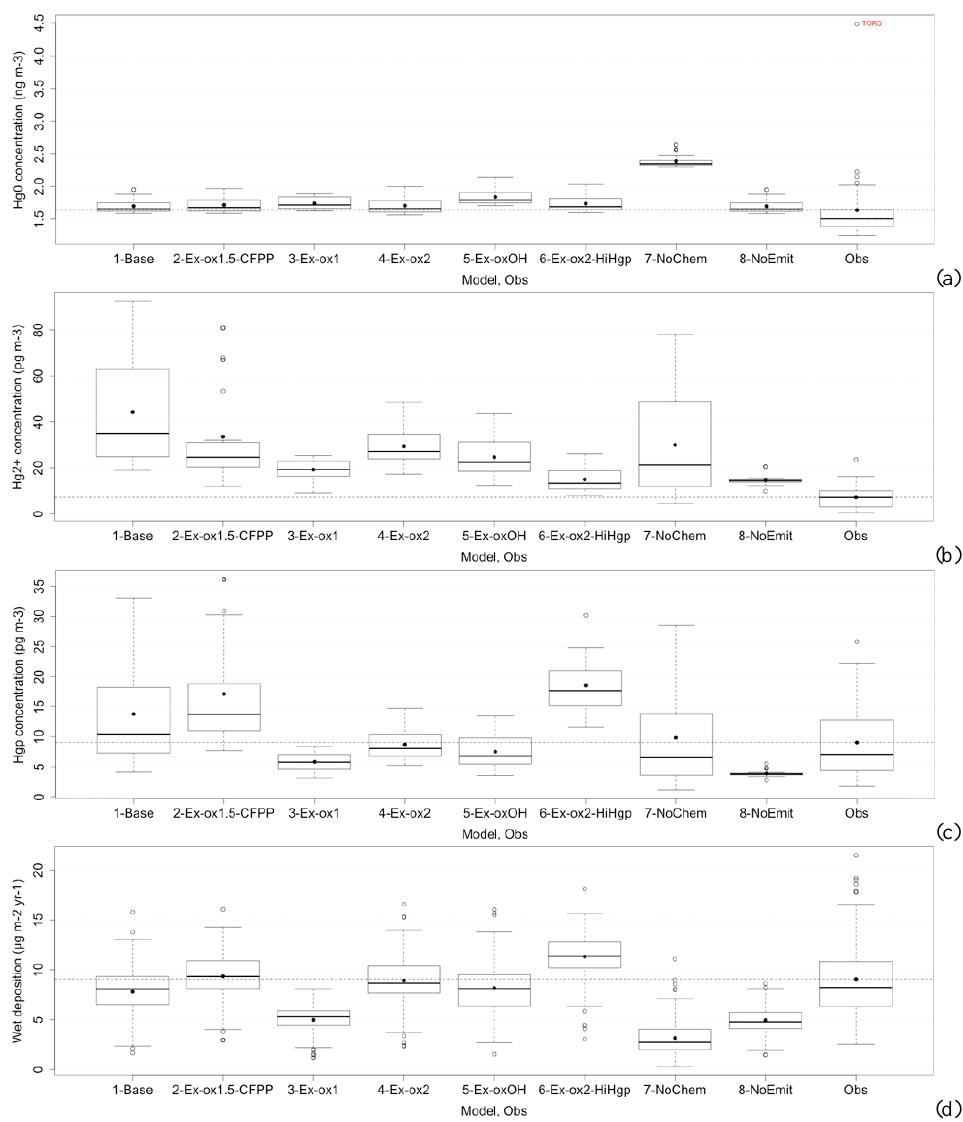
Fig. 3. Spread of yearly means for different model runs and observations. For a detailed model run description, see Table 2. (a) Hg 0 , (b) Hg 2 + , (c) Hg p , (d) wet